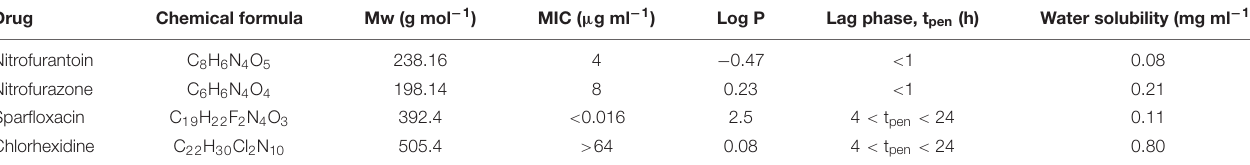
TABLE 2 | Drug characteristics and minimum inhibitory